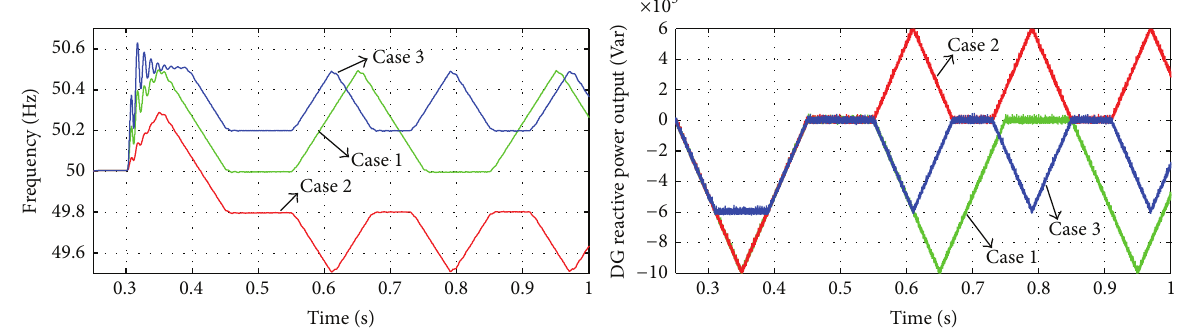
Figure 7: The PCC frequencies and reactive power output of the DG in the second scenario with the improved method.